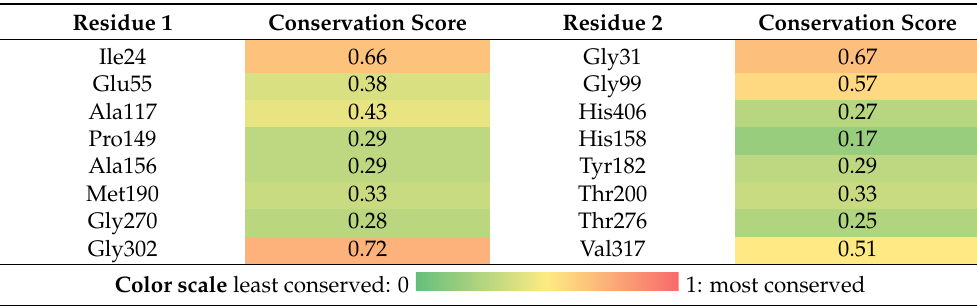
Table 2. The Jensen–Shannon divergence scores for each candidate residue pair. A higher score indicates greater residue conservation. (Residue numbers are according to the PDB 3QVP).